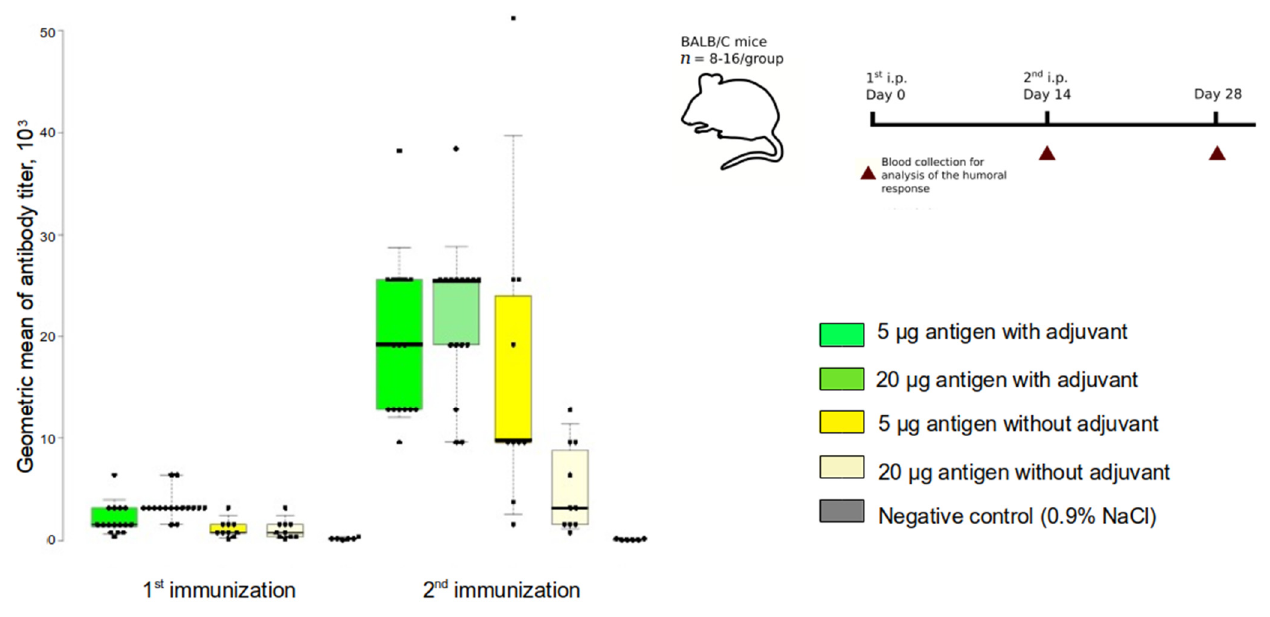
Figure 4. Induction of RBD-specific IgG response following vaccination. The experimental scheme: BALB/c mice of both sexes were vaccinated at Day 0 and Day 14. The presence of anti-SARS-CoV-2 IgG antibodies was analyzed on Day 14 and Day 28. A box and whisker plot of anti-SARS-CoV-2 RBD IgG titers in the serum of immunized mice was made in BoxPlotR; boxes indicate geometric mean titer (GMT) of anti-SARS-CoV-2 RBD-specific IgG titers; Altman whiskers extend to the 5th and 95th percentiles; points indicate individual values; median is shown as horizontal line.